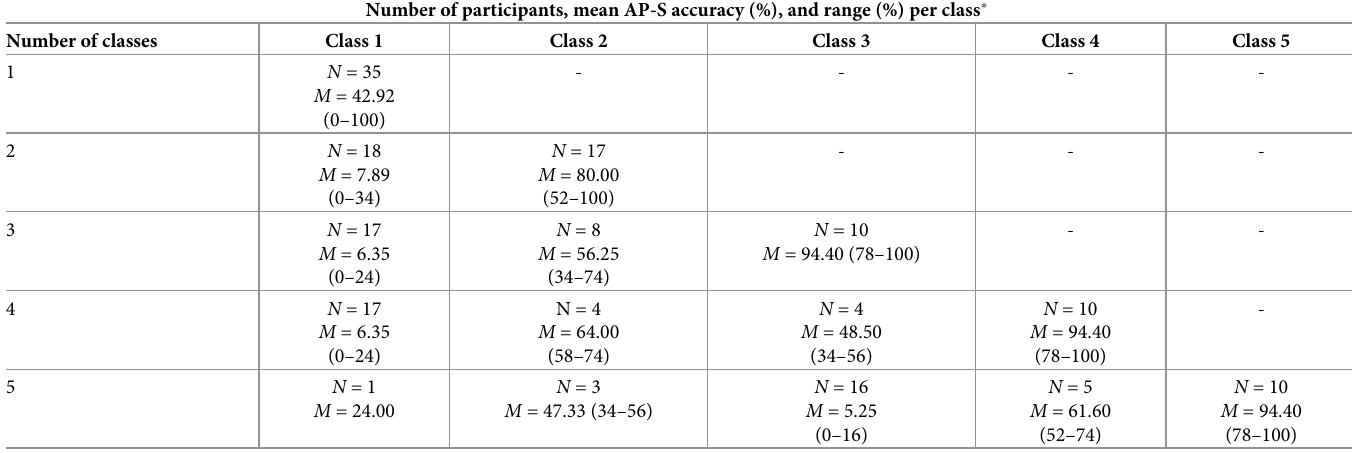
Table 3. Class characteristics in LPA models for